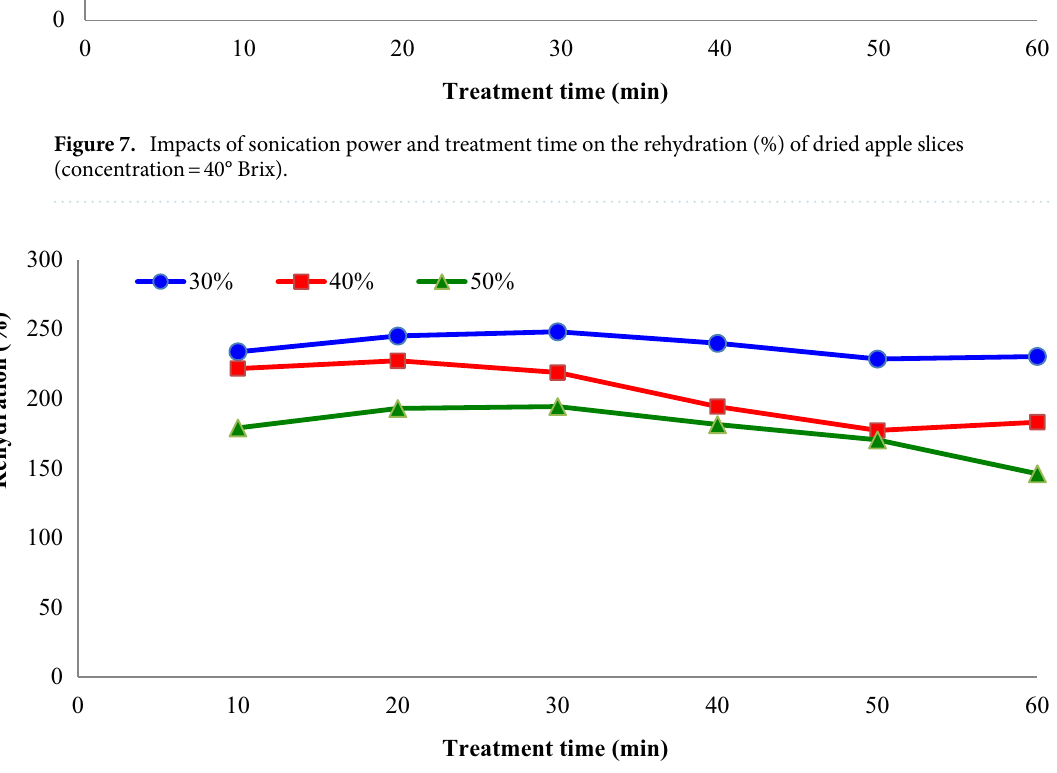
Figure 8. Impacts of sucrose solution concentration (°Brix) and treatment time on the rehydration (%) of dried apple slices (sonication power = 75